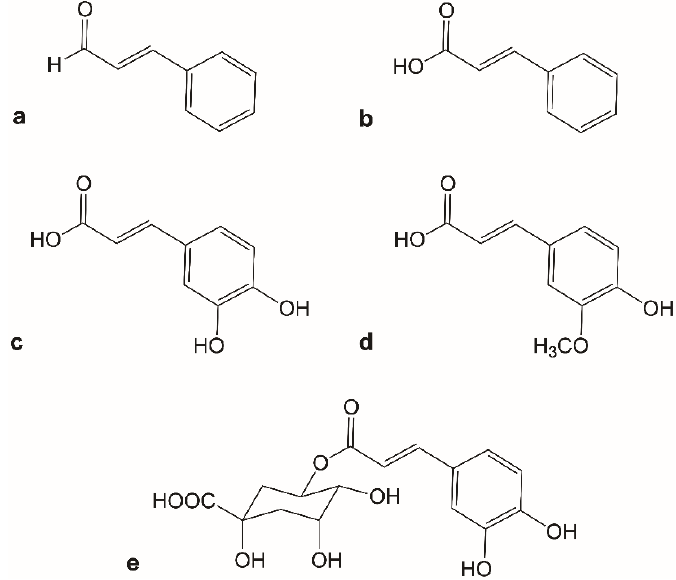
Figure 1. Molecular structures for ( a ) cinnamaldehyde, ( b ) cinnamic acid, ( c ) caffeic acid, ( d ) ferulic acid, and ( e ) chlorogenic acid.